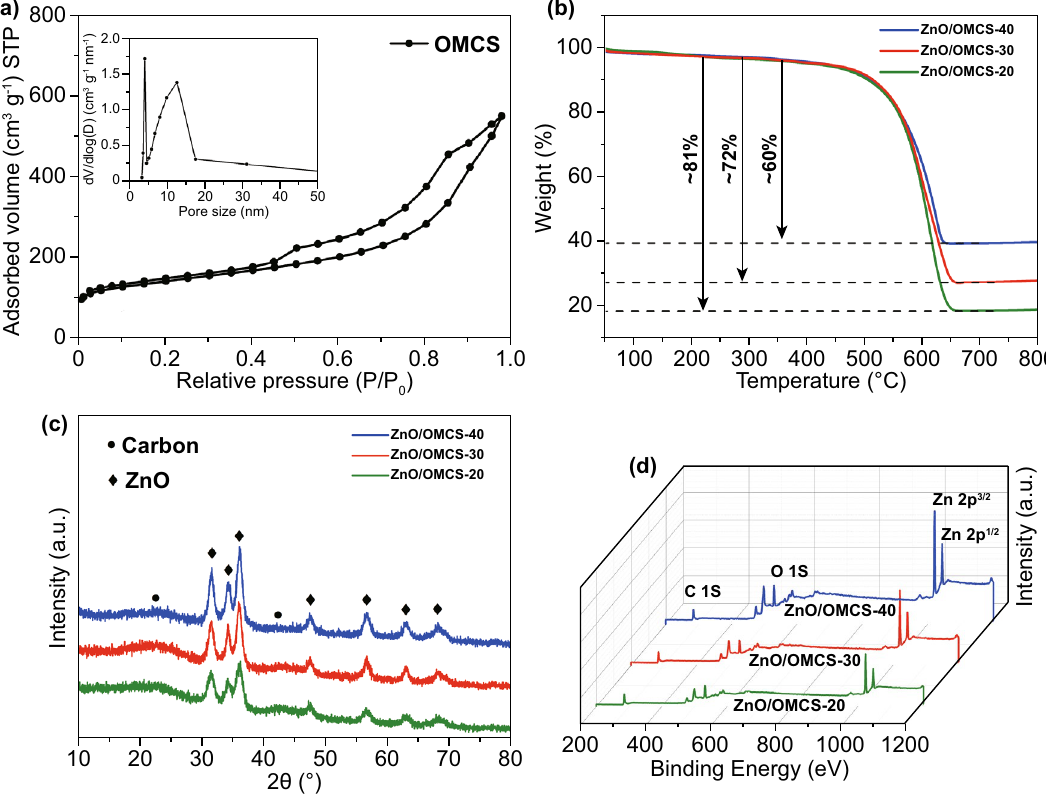
Fig. 3 a N 2 adsorption–desorption isotherms and pore size distribution of the OMCS. b TGA profiles, c XRD patterns, and d XPS spectra for the ZnO/OMCS-20, ZnO/OMCS-30 and ZnO/OMCS-40